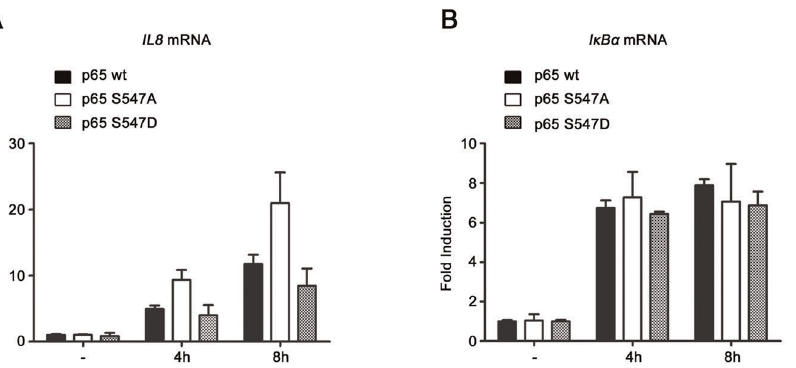
Figure 6. Similar etoposide-induced gene expression profile in cells expressing wt and S547D mutated p65. qRT PCR analysis of IL8 (A), and I k B a (B) mRNA level after 4 and 8 hours of etoposide treatment in HEK-293 cells expressing either p65 wt , p65 S547A , or p65 S547D .